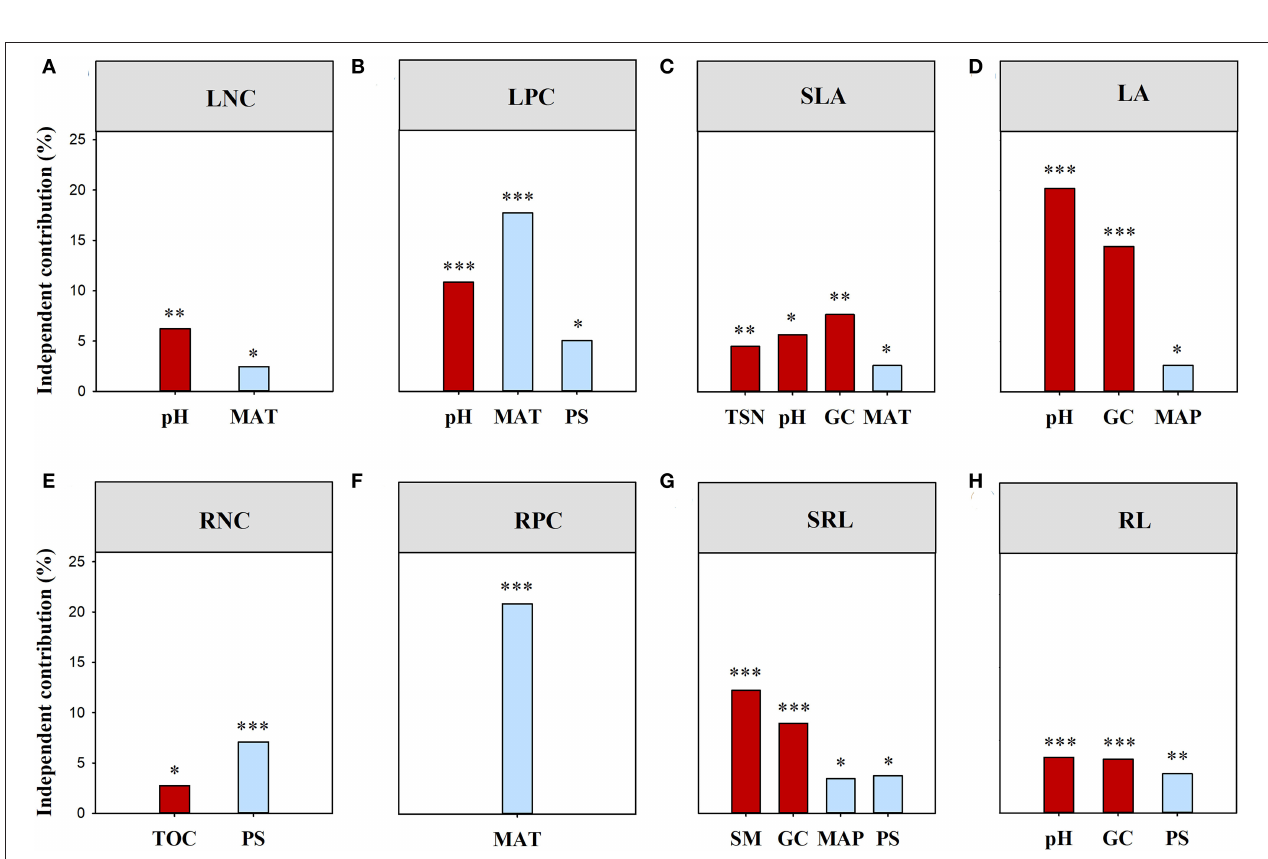
FIGURE 3 | Independent influence of major variables on the variations in phylogenetic (A) and functional (B) structure. All traits, all traits combined; SM, soil moisture; PS, precipitation seasonality, PS; TS, temperature seasonality; GC, gravel coverage. ***, p < 0.001; **, p < 0.01.